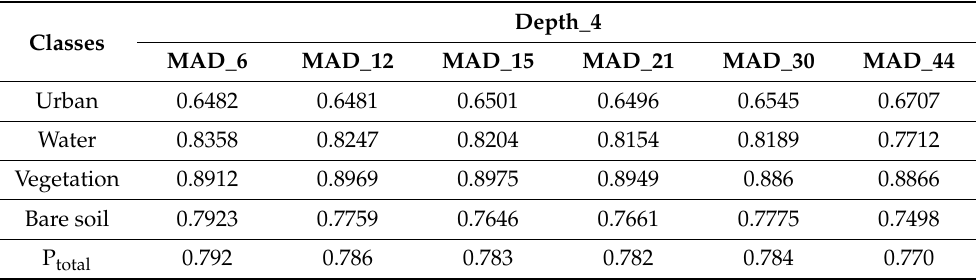
Table 16. Probabilities for classes and total probabilities of correct classification for depth 4 and different MAD.